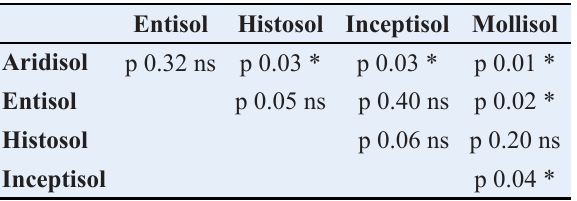
Table 4: Comparison of means of organic carbon in fulvic acids (FA), in the five soil orders Entisol